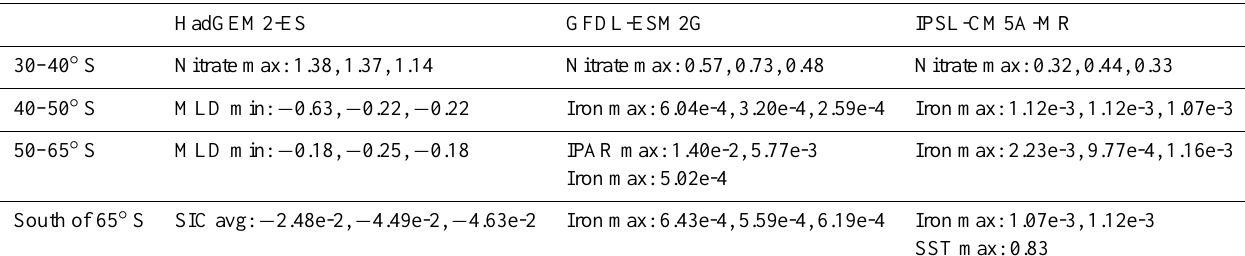
Table 3. Summary of the best-fit line slopes between phytoplankton biomass and given variables of interest, corresponding to Figs. 2 and 3. The first of the three numbers in each table entry is the historical 10-year average slope between PB and the given variable of interest, while the second number is the rcp8.5 10-year average slope, both from Fig. 2. The third number in each entry is the 100-year change spatial correlation slope from Fig. 3. For variable units, see Figs. 2 and